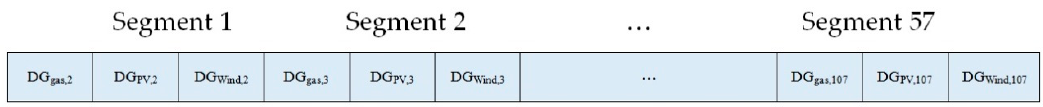
Figure 2. The string of each population.